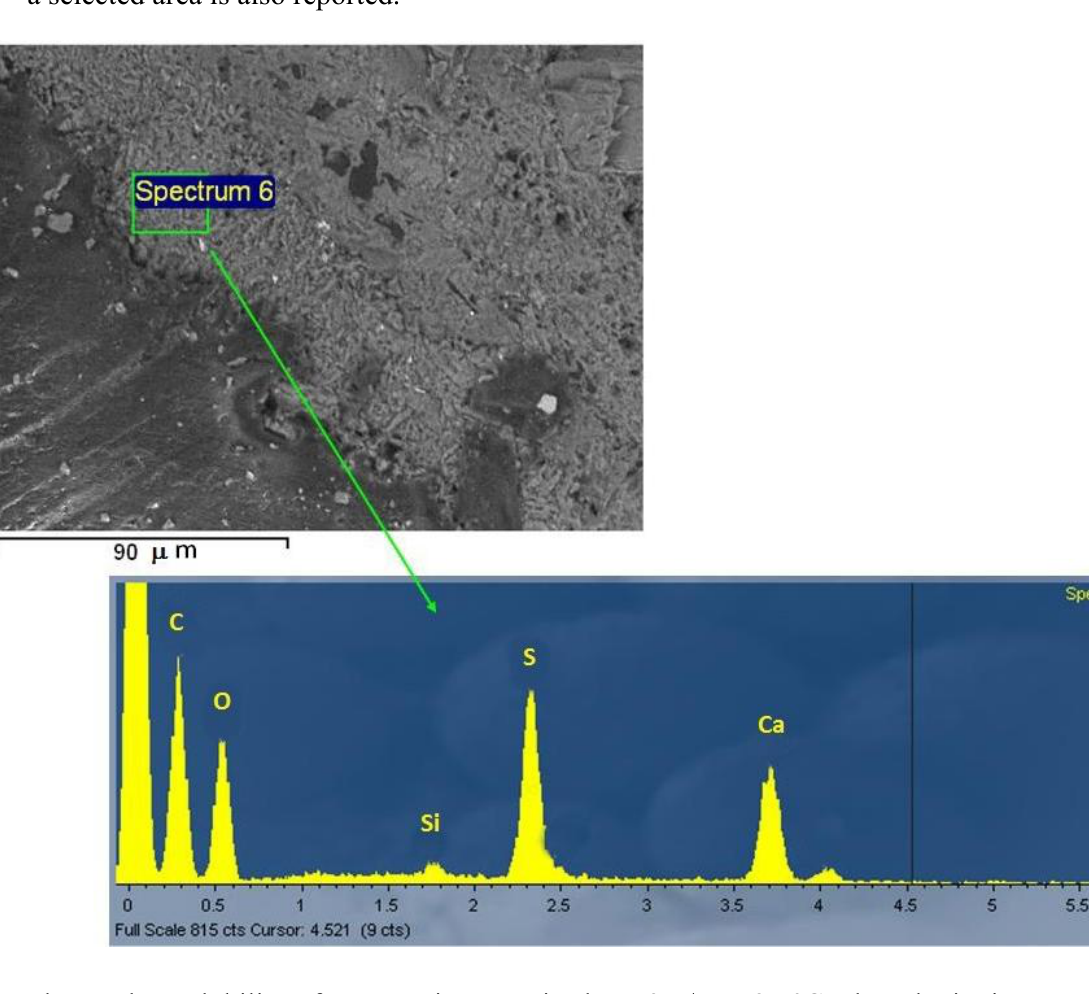
Figure 5. Sample C.3.1.1: SEM image of a black scrub cross section. The EDX analysis of a selected area is also